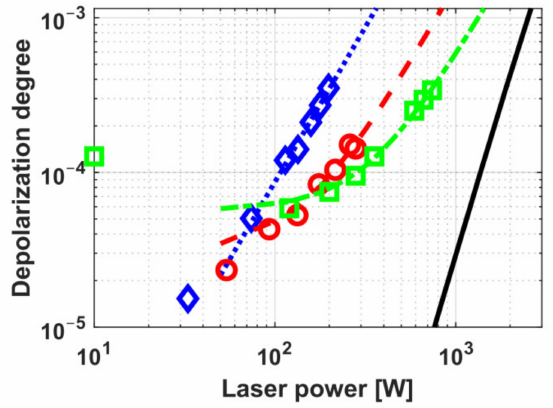
Figure 3. Thermally induced depolarization as a function of laser radiation power in FI based on TGG ceramics without compensation (diamonds—experimental points, dotted curve—theoretical approximation) and with internal (squares and dash-dotted curve) and external (circles and dashed curve) compensation. The solid curve is the theoretical dependence for internal compensation for optical MAE